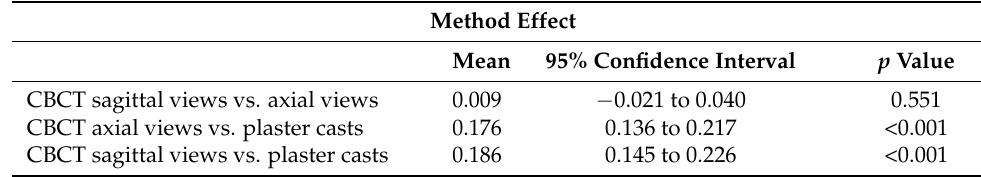
Table 2. Method effects adjusted for observer. Results from the linear regression mixed